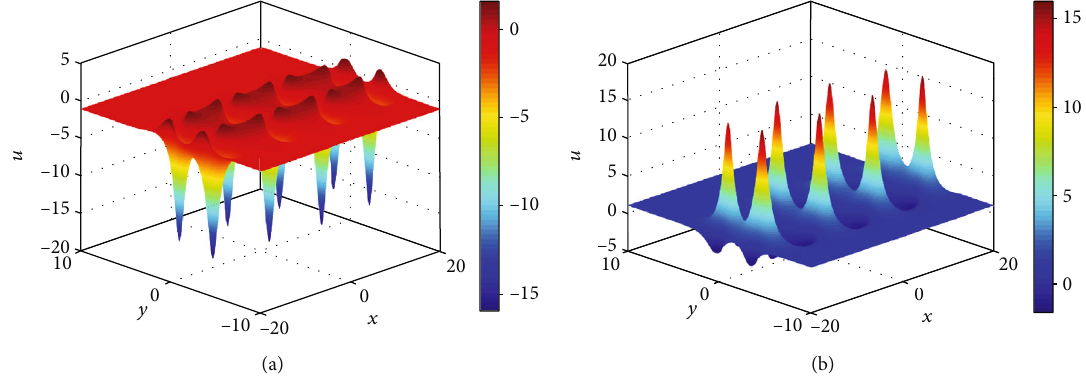
= 1 , b = − 1 , k = − 1/2 , k = i /2 , p = − 1 , p = − 1 , 0 1 2 1 2